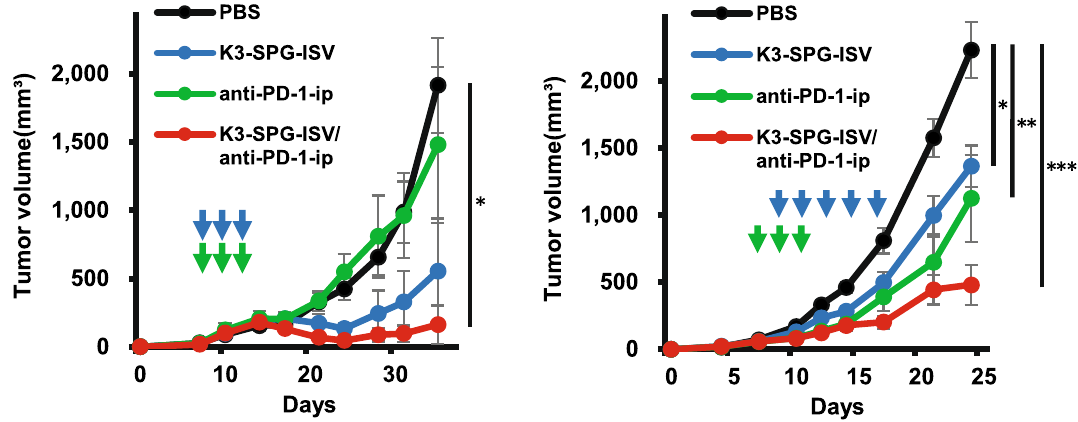
Figure 3. Antitumor activity of K3-SPG-ISV potentiates the effect of PD-1 blockade therapy. (Left panel) Tumor volume was monitored among KPC-N-bearing mice treated with PBS, K3-SPG-ISV (10 μg on days 8, 10, and 12), anti-PD-1-ip (100 μg on days 8, 10, and 12), or a combination of K3-SPG-ISV/anti-PD-1-ip (same dose and schedule as respective monotherapy) (n = 5). Data are representative of two independent experiments with similar results. (Right panel) Tumor volume was monitored among colon-26-bearing mice treated with PBS (n = 43), K3-SPG-ISV (10 μg on days 9, 11, 13, 15, and 17; n = 23), anti-PD-1-ip (100 μg on days 7, 9, and 11; n = 19), or a combination of K3-SPG-ISV/anti-PD-1-ip (same dose and schedule as respective monotherapy; n = 20). The pooled data of six independent experiments of the same protocol are presented. The arrows indicate the timing of therapy. Error bars represent the mean ± SEM. Statistically significant differences were measured by one-way ANOVA followed by the Tukey–Kramer test. * p < 0.05; ** p < 0.01; *** p < 0.001. ip, intraperitoneal.